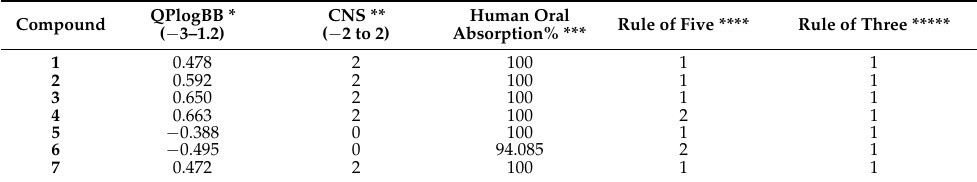
Table 2. Predicted ADME properties of compounds 1 – 7.